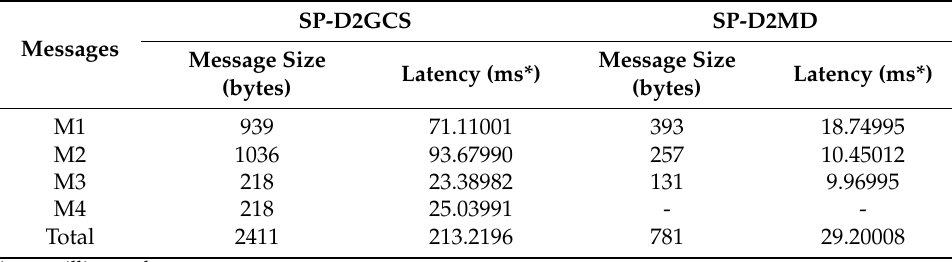
Table 8. Notations and their